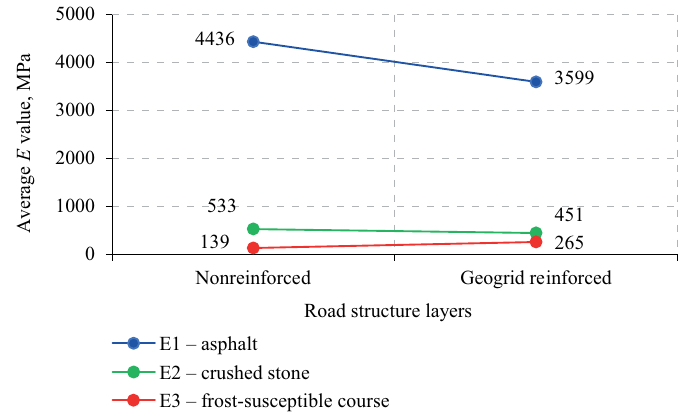
Figure 6. Average values of the bearing capacity in the main road A6 (66.20–68.76 km)